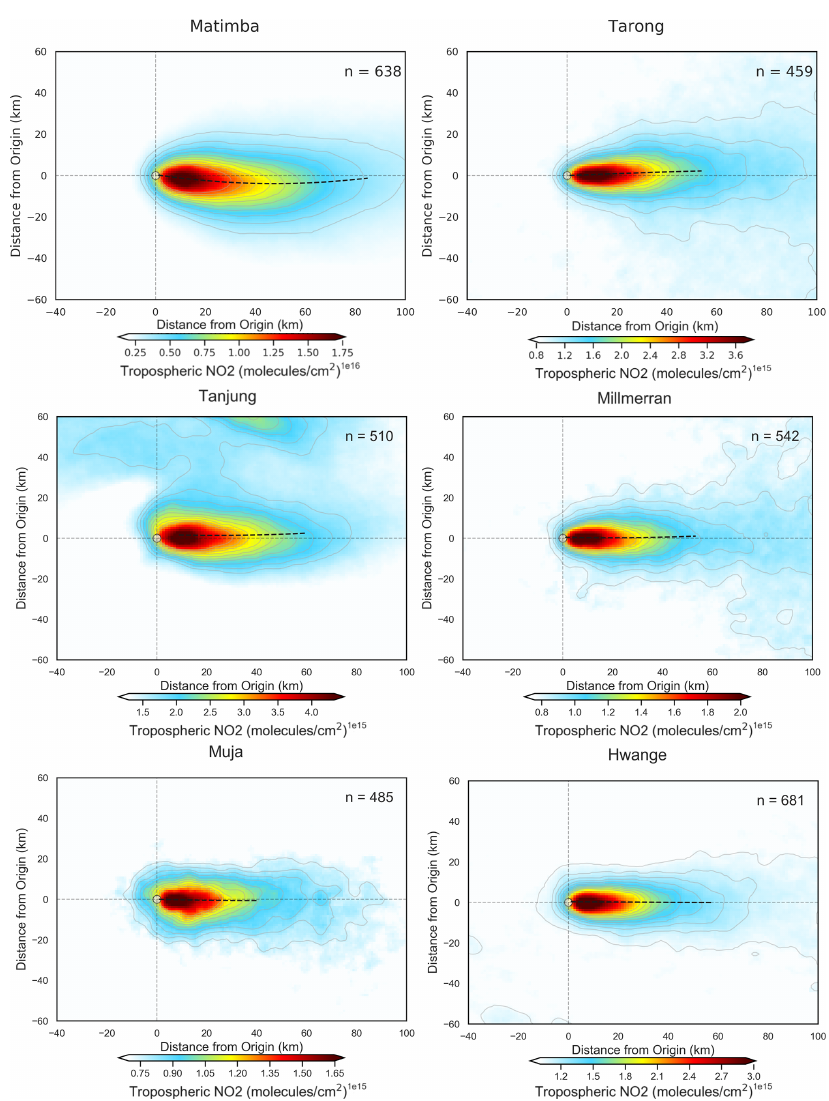
Figure A2. Wind-rotated aggregates of all Southern Hemisphere sites, with the plume spine signified by the dashed black line.